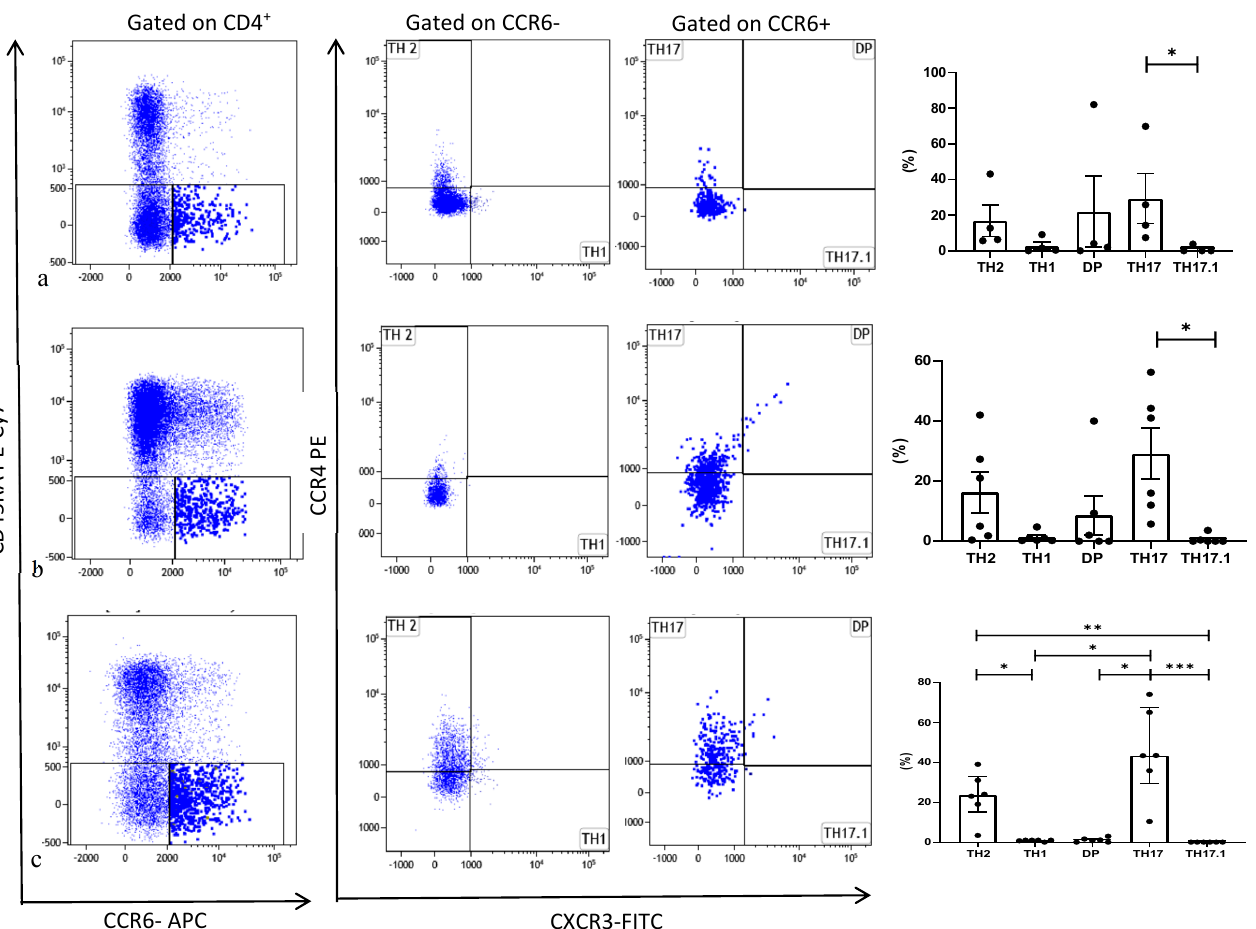
Figure 1. Representative dot plots related to the expression of different chemokine receptors gated in gated CD4 + . T from Stable ( a ), BOS ( b ) and AR ( c ). Three experiments (one for Stable, one for BOS and one for AR) out of 16 are shown. Data represent individual values (dots), mean (center bar) ± SEM (upper and lower bars). If not indicated, p value is not significant. *p<0.05. **p<0.01. ***p<0.001.